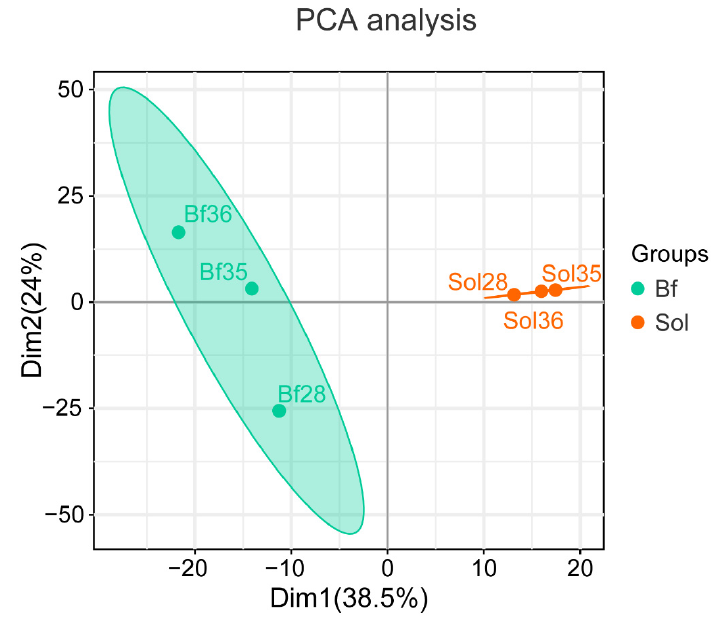
Figure 2. Principal component analysis (PCA). Based on the expression of the identified proteins, PCA was carried out to visualize the differences between Bf and Sol samples. According to the criteria of a fold change ≥ 1.2 or ≤ 0.83 and a p -value < 0.05, 126 DAPs between Bf and Sol were identified in this study, including 38 downregulated DAPs and 88 upregulated DAPs (Figure 3, Table S4).